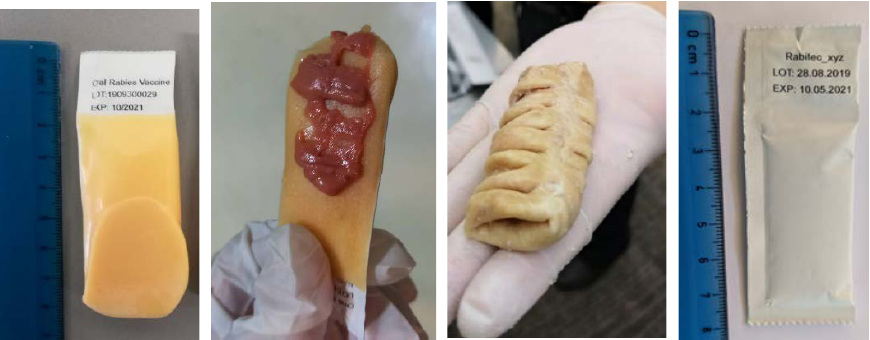
Figure 2. The egg bait (left), egg+ bait (middle left), and intestine bait (middle right) used in the field studies and vaccine sachet (right).